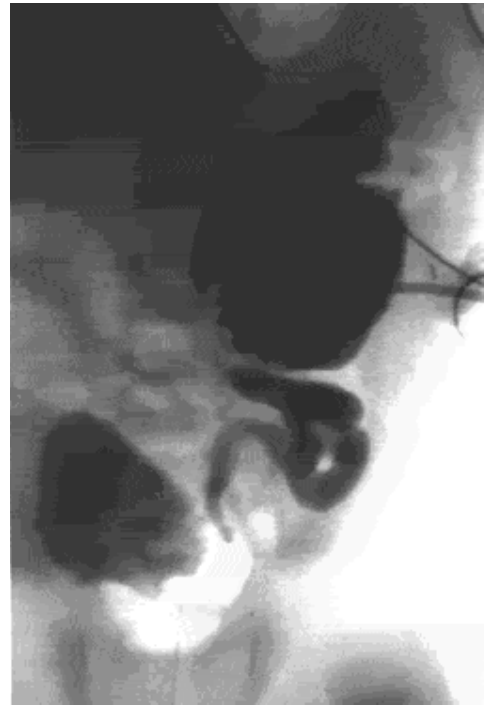
FIGURE 4. Left antegrade nephrostogram demonstrating non-obstructed flow into the